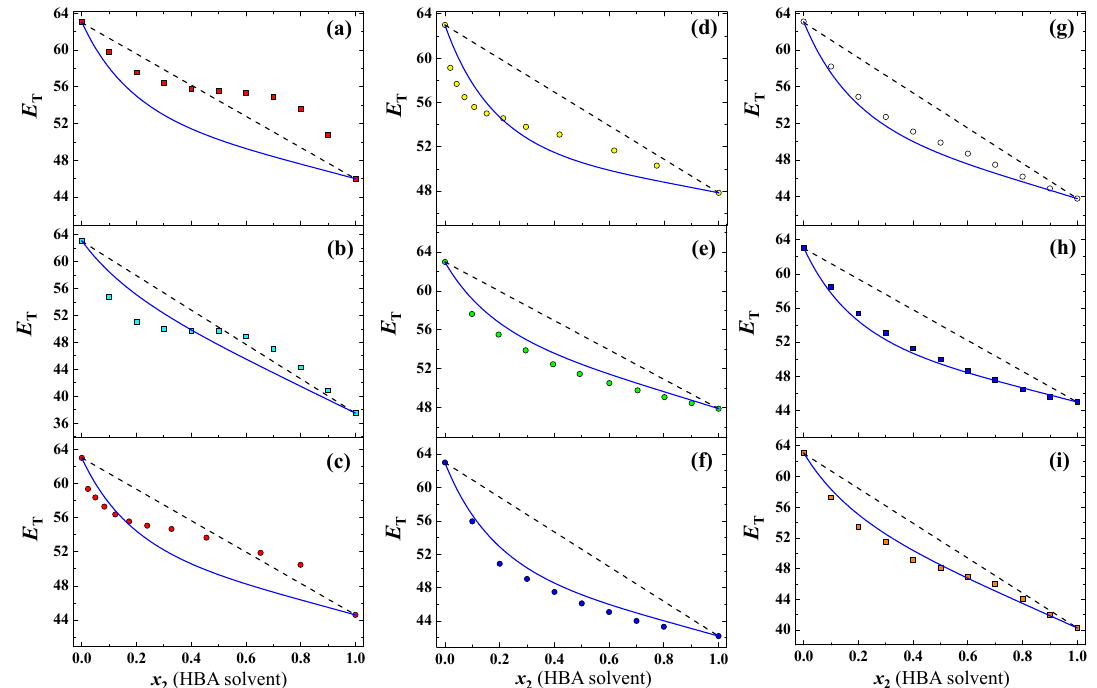
Figure 5. Electronic transition of ( E T (30), kcal · mol − 1 ) of nine aqueous mixtures of water (1)—hydrogen bond acceptor (HBA, 2) as a function of mole composition of component 2 ( x 2 ) at 25 °C. Symbols ( a – i ) and reference sources are given in Table 2 (entries 1–9). Black dashed lines show calculations from the ideal model (Equation (1)). Blue solid lines show predictions with the predictive model (Equation (2)) without considering HBD contribution factor ( CF HBD = 1).